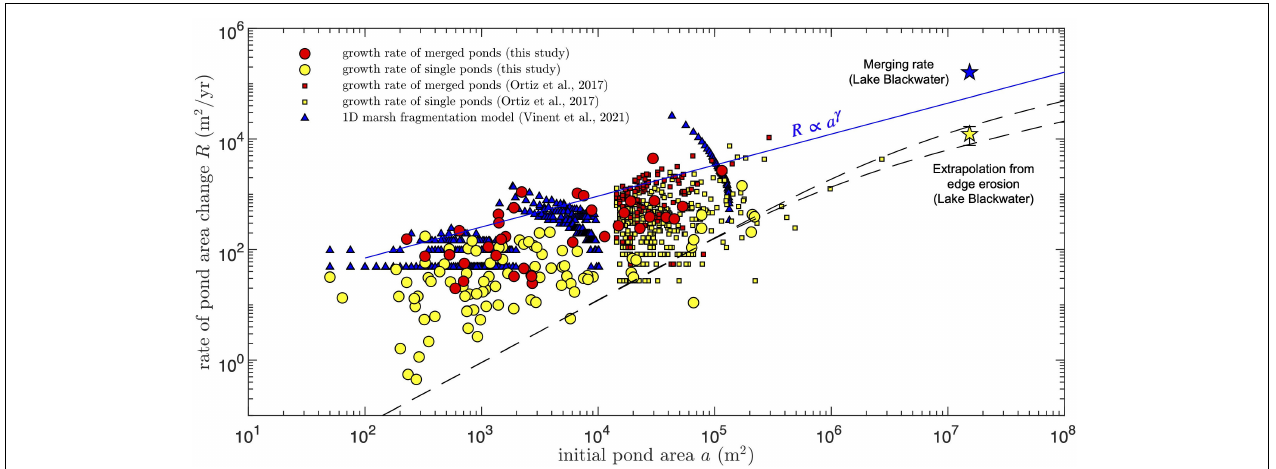
FIGURE 8 | Comparison of measured and simulated pond area growth rates as function of the initial pond size. For the growth rate of merged ponds, the initial area is defined as the combined area of all merging ponds. For the one-dimensional model, the simulated pond area is calculated by multiplying the simulated pond length by a constant pond width obtained from the condition that the smallest simulated pond has an area of 50 m 2 (the smallest area resolved in the measurements). Data reported by Ortiz et al. (2017) in the Mississippi delta was selected by the condition that the final pond area is no larger than four times the initial area, to conserve a meaningful correlation between both. Star symbols and dashed and solid lines as in Figure 6